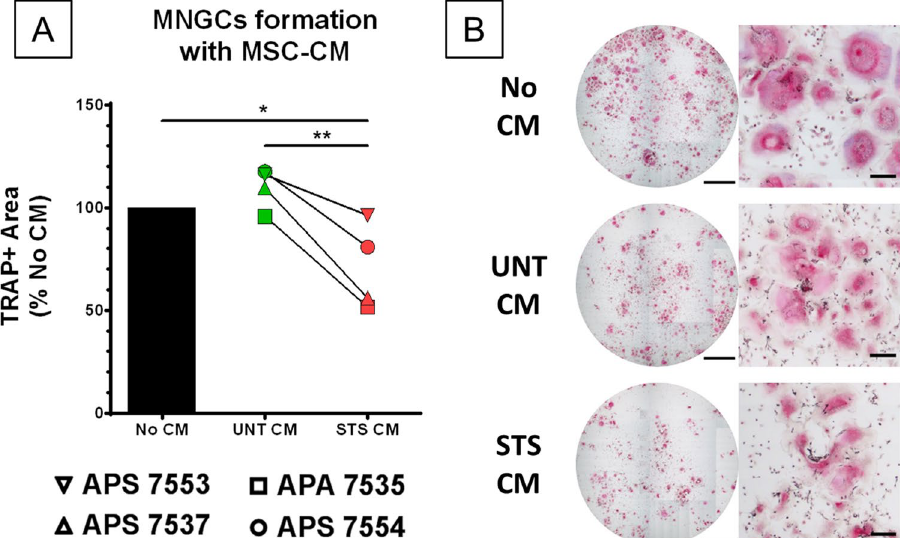
Figure 4. CM from STS-treated MSCs inhibit the development of GM-CSF/IL-4 induced MNGCs. ( A ) Quantification by image analysis of TRAP+ area after 8 days of MNGC differentiation with UNT or STS CM from four MSC donors, normalized to the TRAP+ area without CM. N = 4 independent experiments with technical triplicate. Statistical analysis by repeated measure ANOVA followed by Tukey’s multiple comparison test, * for p value < 0.05, ** for p value < 0.01. ( B ) Full well (scale bar = 2 mm) and close-up (scale bar = 200 µm) images of TRAP-stained MNGCs at 8 days of differentiation without CM, with UNT-CM and